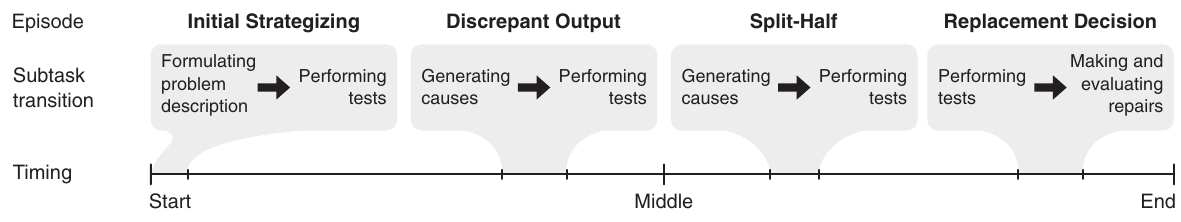
FIG. 2. Representation of the ordering and typical duration of episodes selected for analysis. In all interviews, episodes occurred in the order shown here. In half the interviews, either the split-half episode or the replacement decision episode was missing; in these cases, the other three episodes still occurred in the order shown. Across all interviews, all four episodes together accounted for about 20% of the total time spent troubleshooting during the interviews. On average, initial strategizing episodes had the shortest duration. Students typically spent 20 to 45 min troubleshooting the